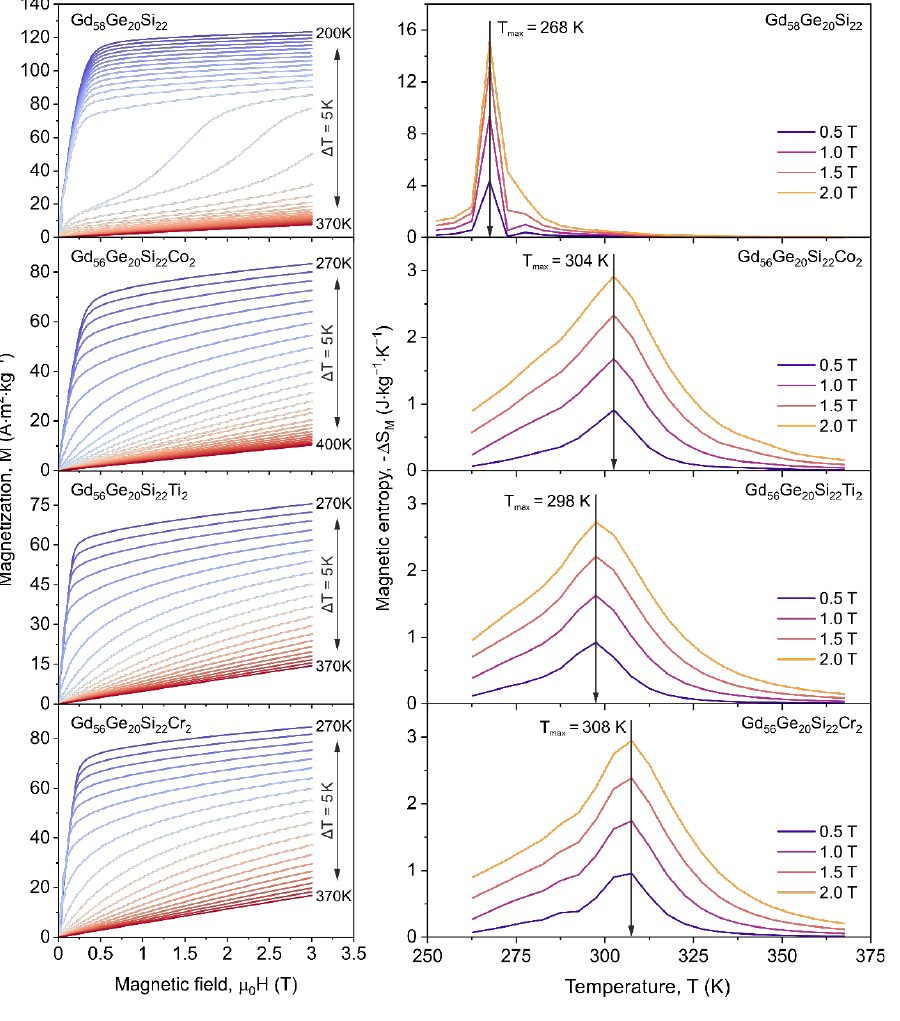
Figure 5. Set of isothermal M( μ 0 H ) curves and corresponding magnetic entropy changes versus temperature calculated for the Gd 58-x Ge 20 Si 22 Y x (x = 0 or 2; Y = Co, Ti or Cr) alloys at the maximum external magnetizing field of 0.5 T, 1.0 T, 1.5 T and 2.0 T.